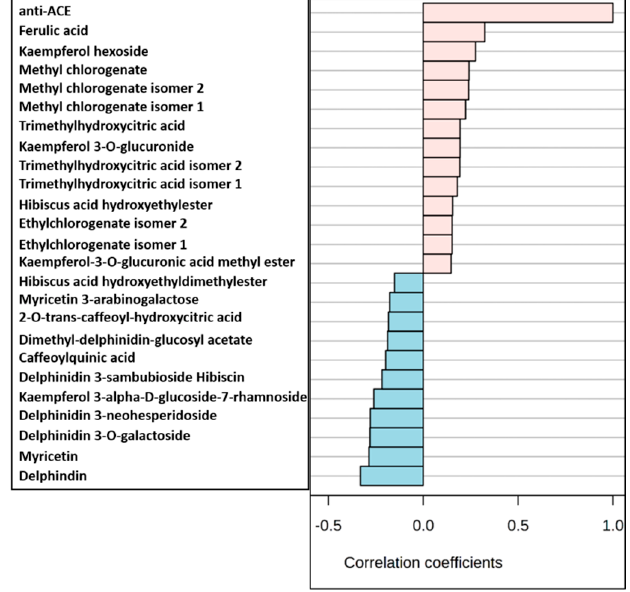
Figure 6. Top 25 metabolites correlated with angiotensin converting enzyme (ACE) inhibiting activity. Pearson’s correlation coefficients indicating the relationship between metabolites content and the ACE inhibition.